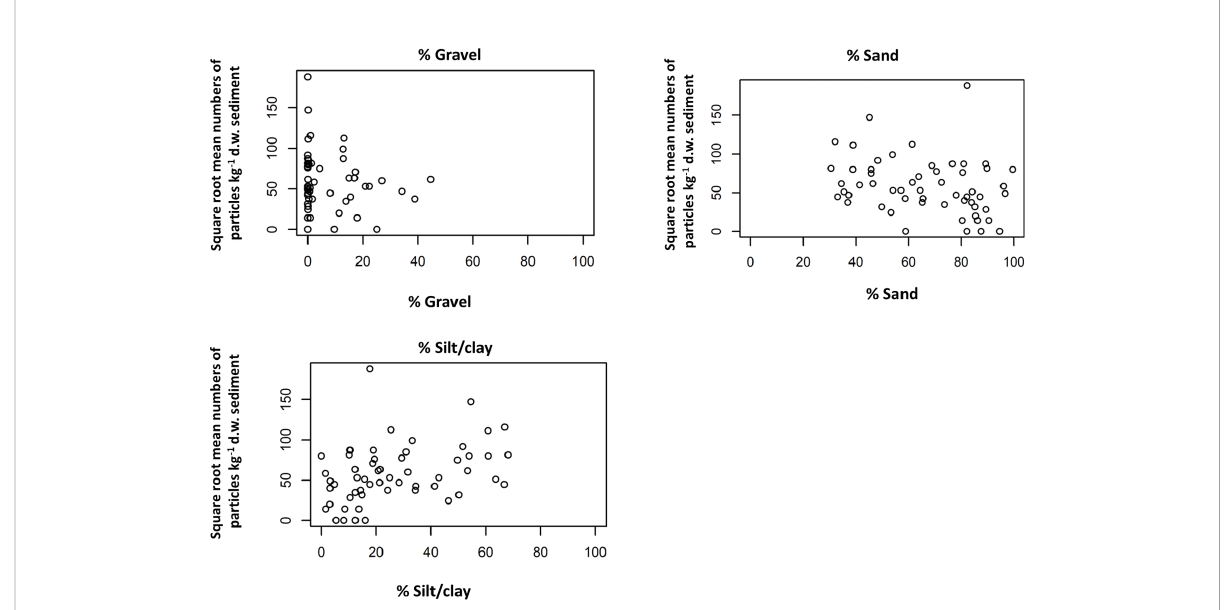
FIGURE 7 Plots of square root of the mean number of particles kg -1 d.w. sediment against PSA expressed as % Gravel, % sand and % Silt/clay.